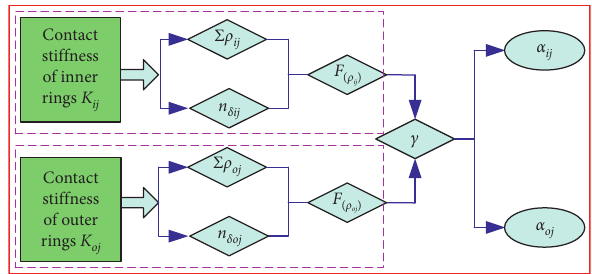
Figure 6: Analysis of variable transfer relationship of contact point stiffnesses K ij and K oj